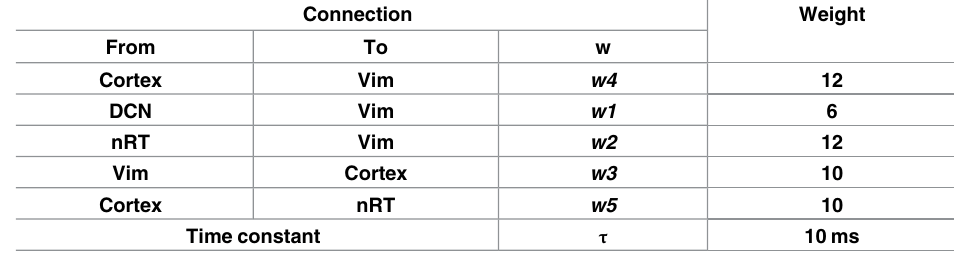
Table 2. Model parameters. The free parameters used in the Wilson-Cowan model of the thalamocortical- cerebellar network for essentialtremor. The weight parametersfor the six connections and the time constants in the model network are given here, and all other parameters are listed in the text. These parameters were selectedprior to the bifurcation analysis, by sweepingthe parameter space and were chosen to be close to the bifurcation point where the oscillationexists with the correct frequency. The w symbols are those appear- ing in the four equations describing the network in the methods section. Connection Weight From To w Cortex